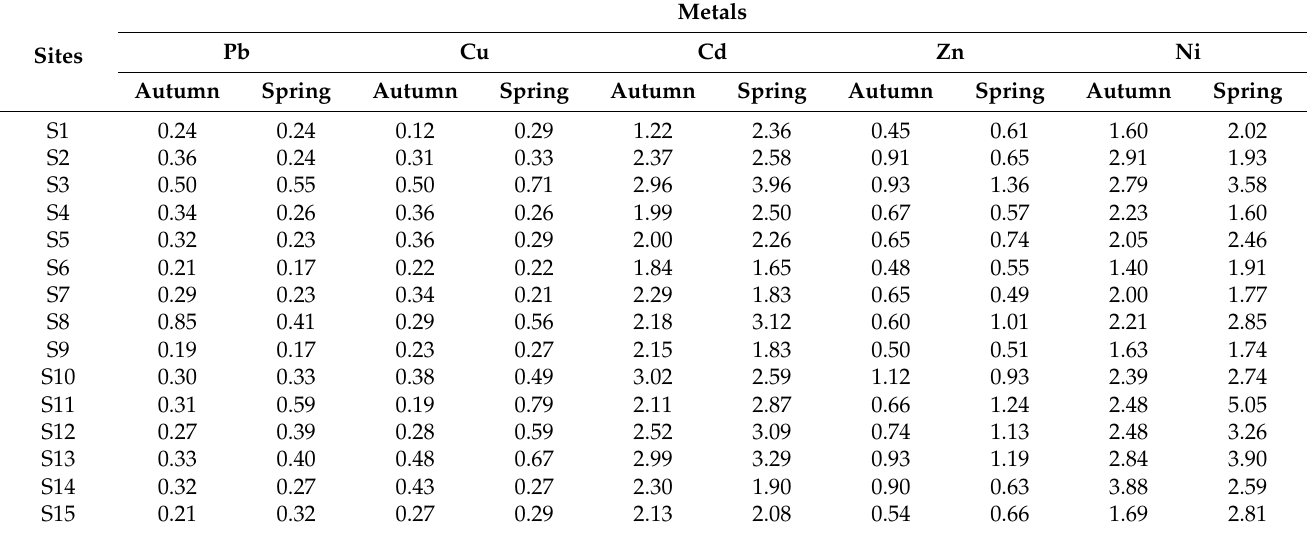
Analyzing the spatial distribution of the PLI related to the two monitored seasons (the autumn of 2018 and the spring of 2019), it can be observed that the PLI values ranged from 0.53 (S1) to 1.17 (S3) in the autumn months, which indicates the absence of heavy metal pollution ( PLI < 1) in 73% of the monitored stations. During spring 2019, Figure 3 illustrates that PLI values ranged from 0.57 (S6) to 1.53 (S11), indicating the presence of sediments heavy metal pollution, especially in monitoring stations S11–S13 ( PLI > 1).